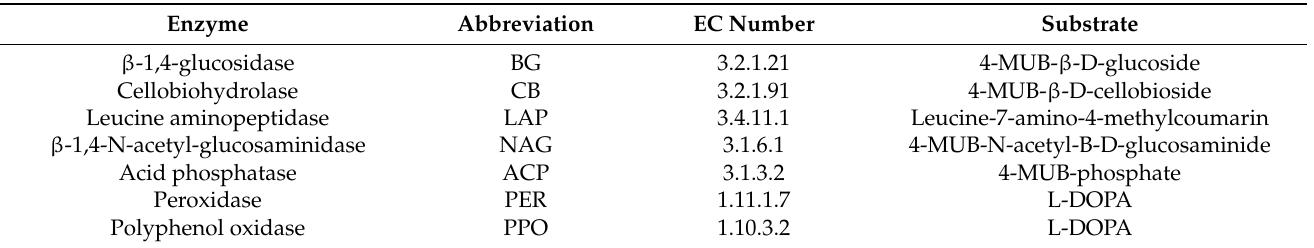
Table 1. Extracellular enzyme assayed in cucumber soil, their enzyme commission number, and the corresponding